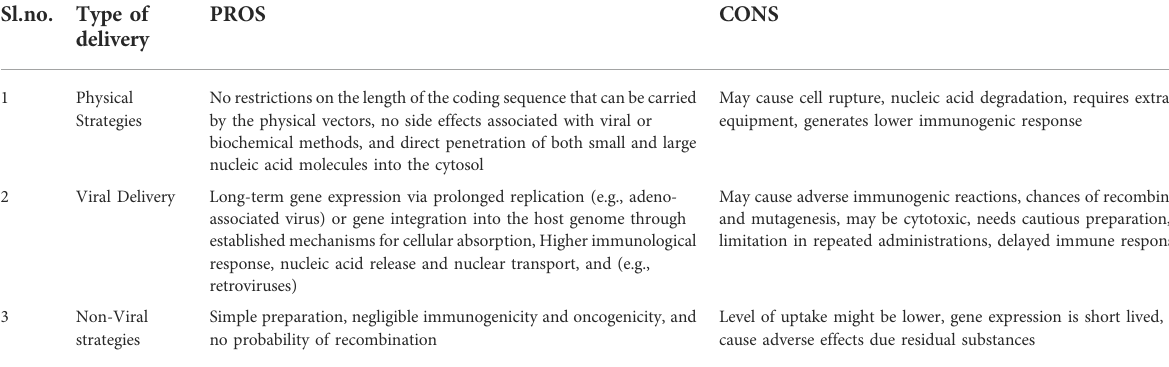
TABLE 3 Table of different strategies used to deliver nucleic acid cargo to